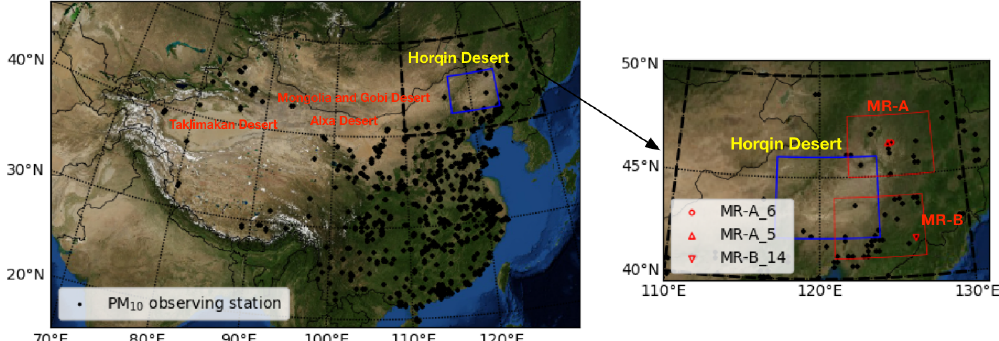
Figure 2. Locations of the Mongolia and Gobi, Alxa, Taklimakan, and Horqin deserts. The dots indicate locations of China MEP air quality monitoring sites. Red marked region A (MR-A) and marked region B (MR-B) are where the dust is observed but not reproduced using the transport model in this study.